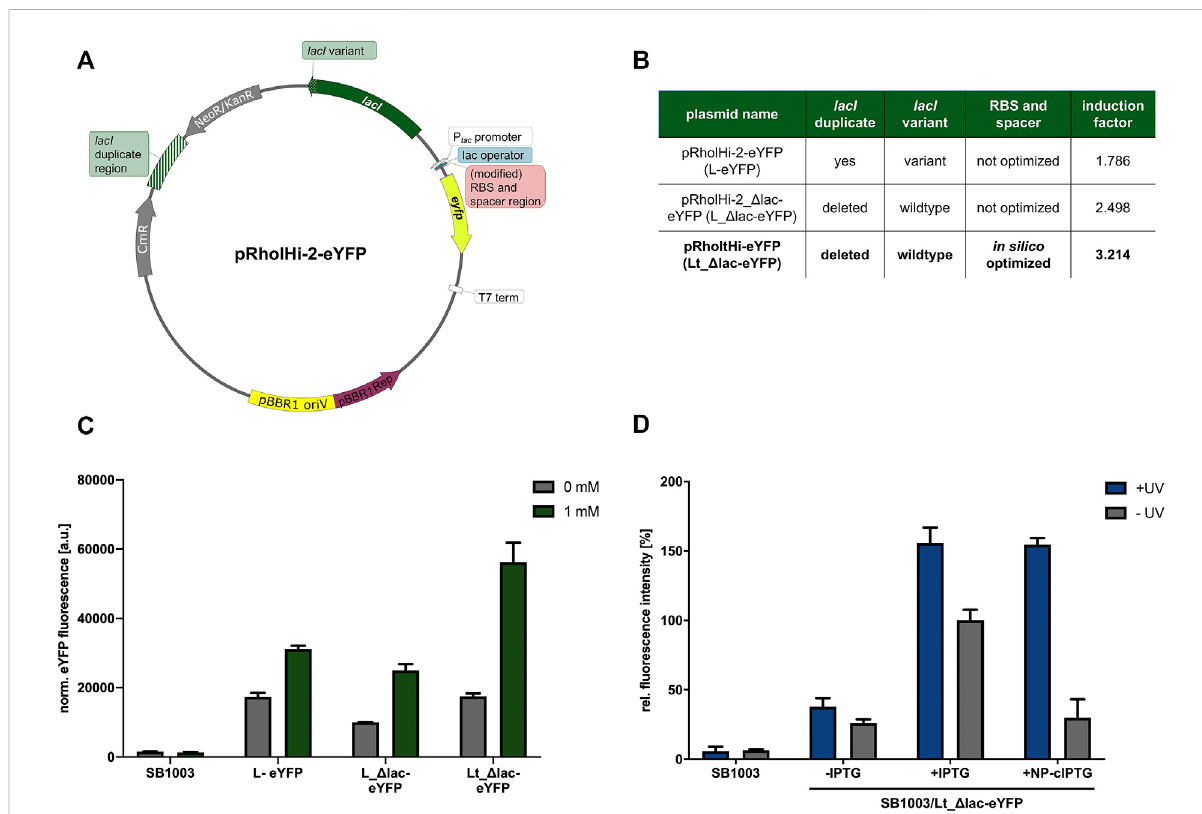
FIGURE 4 Optimization of expression plasmid pRholHi-2-eYFP. To improve the properties of the expression plasmid pRholHi-2-eYFP (A) several engineering stepswereconducted (A,B) .First,adefective lacI gene( lacI variant) wasexchangedbythecorrespondingwildtype lacI genefrom E.coli K12. Secondly, a 519-bp lacI -homologous DNA fragment approximately 1.5 kb upstream of the lacI gene was deleted ( lacI duplicate region). Additionally, the ribosome binding site (RBS) consisting of the Shine-Dalgarno (SD) sequence, and its corresponding downstream spacer was replaced by an in silico optimized version. The induction factors of the respective expression systems were calculated as the ratio of the normalized eYFP fl uorescence values of induced and non-induced cultures. (C) After construction, the three plasmid variants were evaluated regarding their resulting basal expression levels and induction factors in phototrophically grown R. capsulatus SB1003 cultures. Biomass-normalized eYFP in vivo λ fl uorescence ( λ ex = 508 nm, em = 532 nm) of cultures supplemented with 1 m M IPTG is shown in comparison to uninduced cultures and